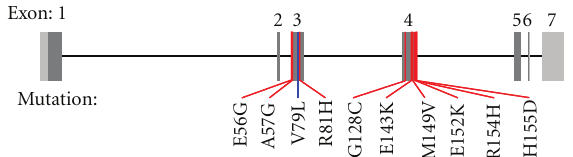
Figure 2: The genomic structure of MYL3 with the localization of known disease causing mutations indicated.